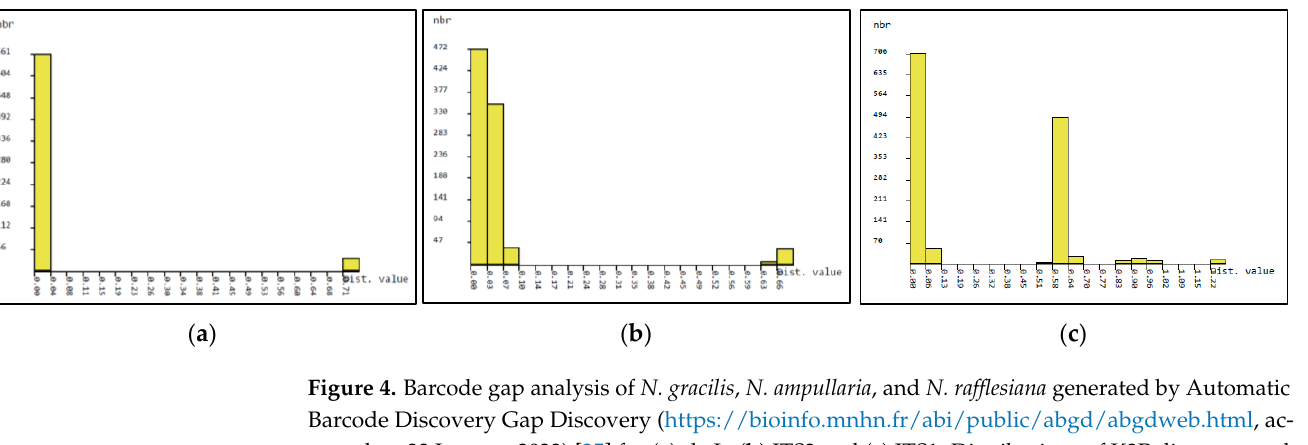
Figure 3. Neighbor joining tree of rbc L ( a ), ITS1 ( b ) and ITS2 ( c ) barcode primers depicting the phy- logenetic analysis among N. ampullaria, N. gracilis, and N. rafflesiana (indicated in the red boxes). Figure 4. Barcode gap analysis of N. gracilis , N. ampullaria , and N. rafflesiana generated by Automatic Barcode Discovery Gap Discovery (https://bioinfo.mnhn.fr/abi/public/abgd/abgdweb.html, ac- cessed on 23 January 2023) [25] for ( a ) rbcL, ( b ) ITS2 and ( c ) ITS1. Distributions of K2P distances and between each pair of specimens for the histogram of distance.